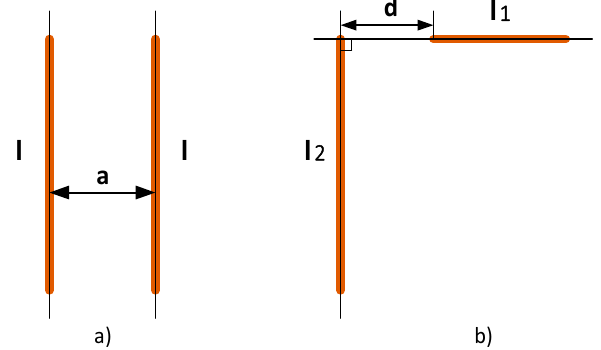
Figure 4. Conductors of finite length: ( a ) parallel conductors of the same length separated by distance a , ( b ) conductors of different length at the right angle and separated by distance d .